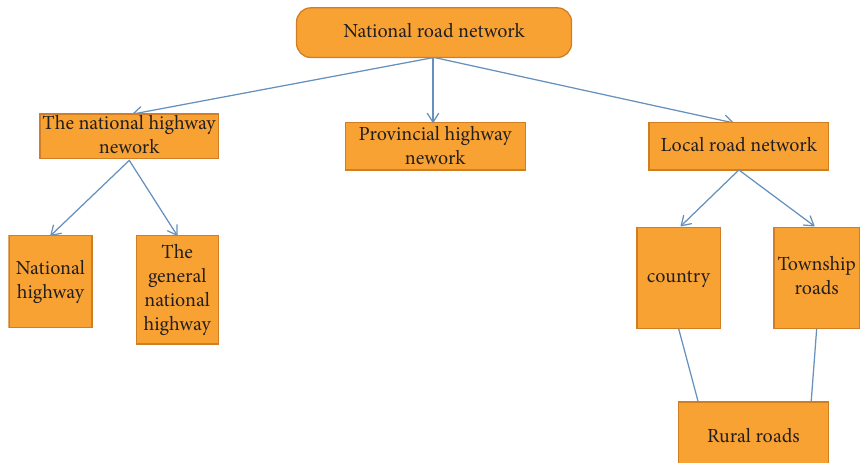
Figure 3: Classification of the national highway network according to administrative